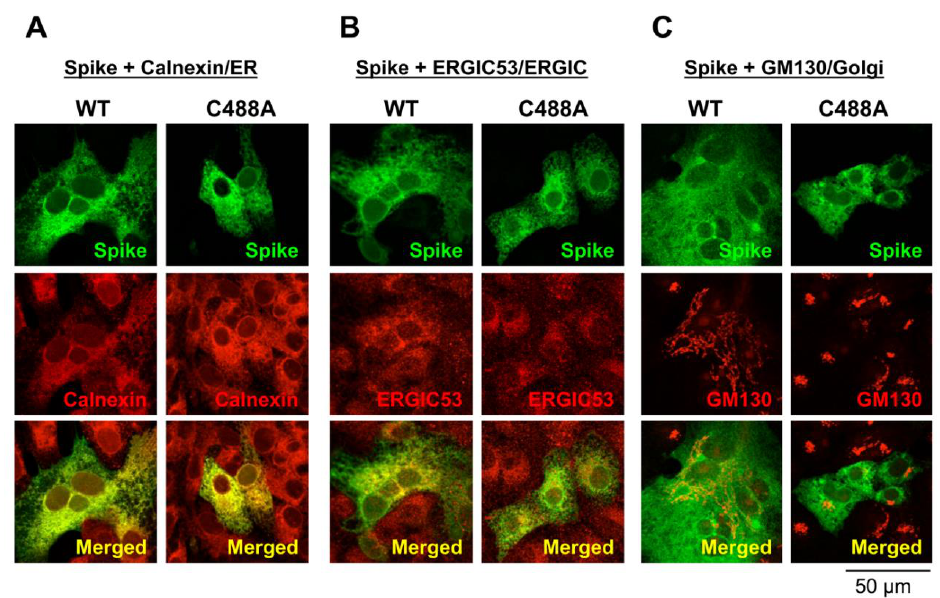
Figure 2. Subcellular localization of C488 mutant spike protein in Vero cells. Wild-type (WT) and C488A mutant spike-expressing plasmids were expressed in Vero cells for 2 days, and their subcellular co-localization with ( A ) calnexin, ( B ) ERGIC53, and ( C ) GM130 were analyzed by confocal microscopy. WT and C488A mutant spikes (green signals) were probed with anti-spike (1A9) antibodies and subcellular markers (red signals) used were: calnexin, ERGIC53, and GM130 as ER, ERGIC, and Golgi markers, respectively. A co − localized yellow signal is visualized in the merged images (lower panels).